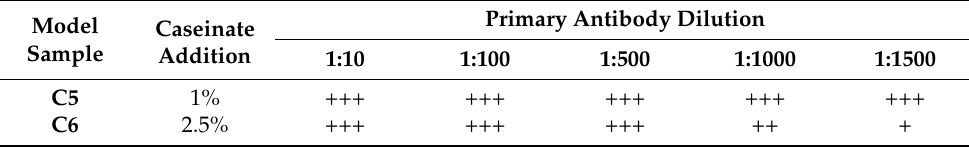
Table 1. Effect of primary antibody dilution on IHC detection of beta-casein in selected model samples. Model